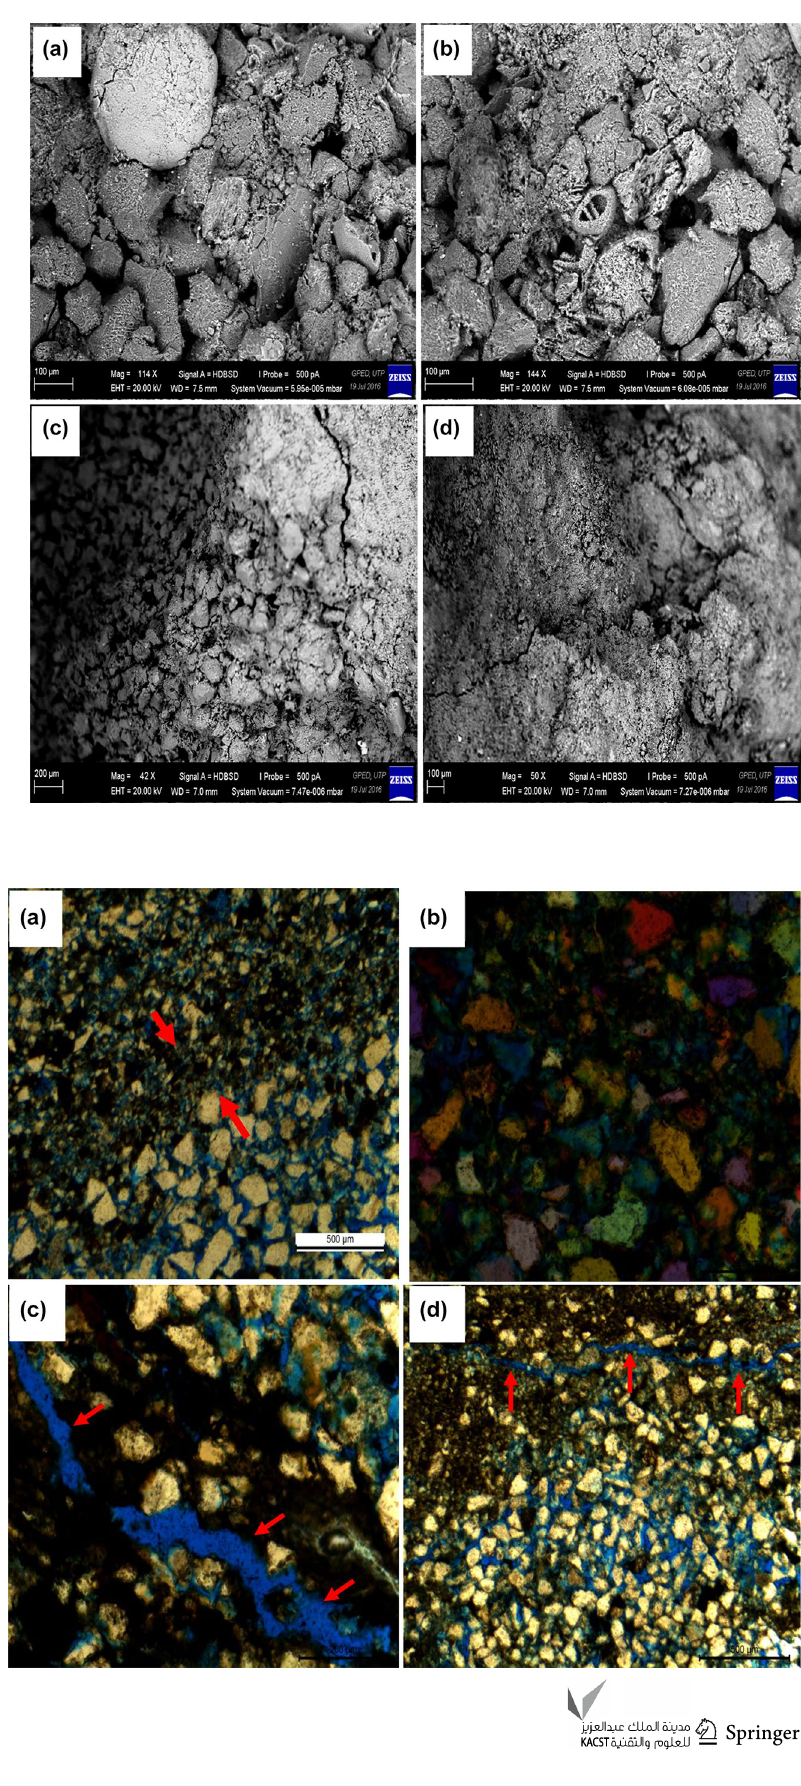
Fig. 9 SEM images of repre- sentative photomicrographs of massive fine-grained sandstone (MFGS) showing different pore types: ( a ) grain shapes, sorting/ packing, ( b ) fine-grained matrix fraction obliterating intergranu- lar pores, ( c ) matrix-fracture pore and ( d ) matrix-fracture pore indicated by red arrows